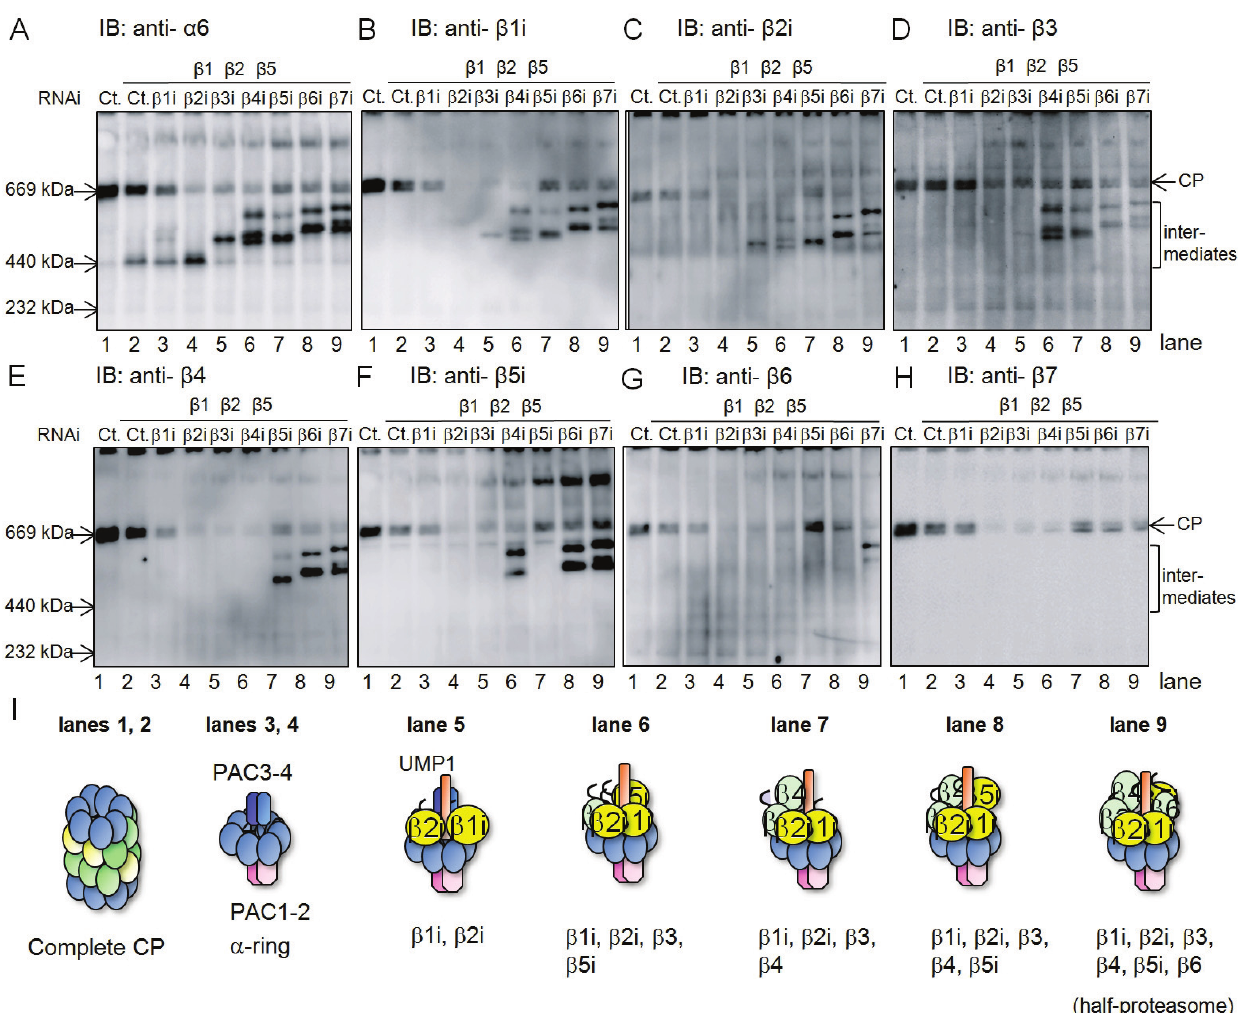
further supported by the observation that (cid:2)1i and (cid:2)2i were detected in all the intermediates except